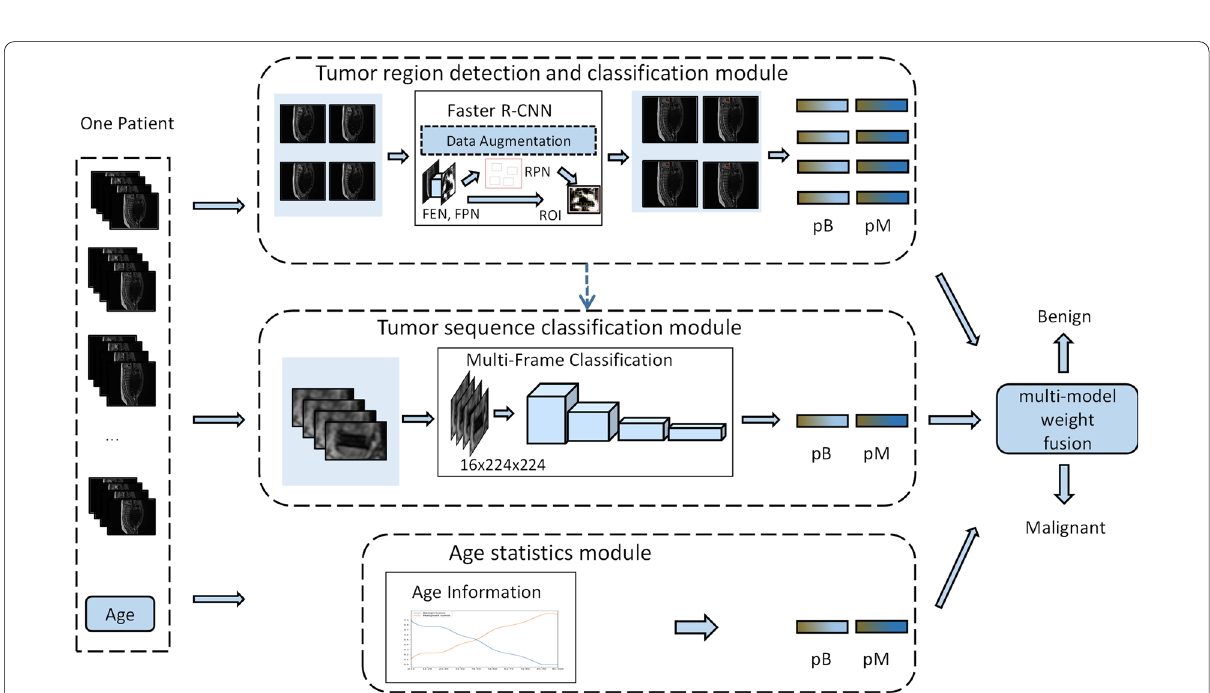
Fig. 2 The proposed multi-model weighted fusion framework